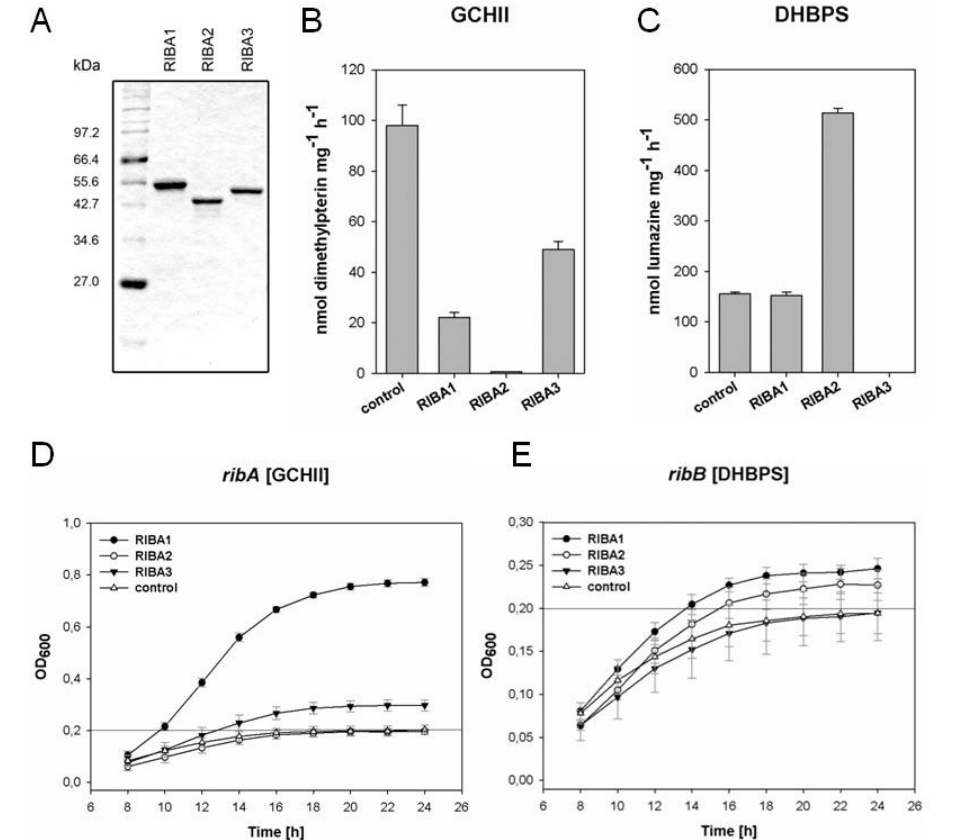
Figure 5. Enzymatic activities of AtRIBA proteins. ( A – C ) His-tagged N -terminally truncated AtRIBA proteins were overexpressed in E. coli and purified by